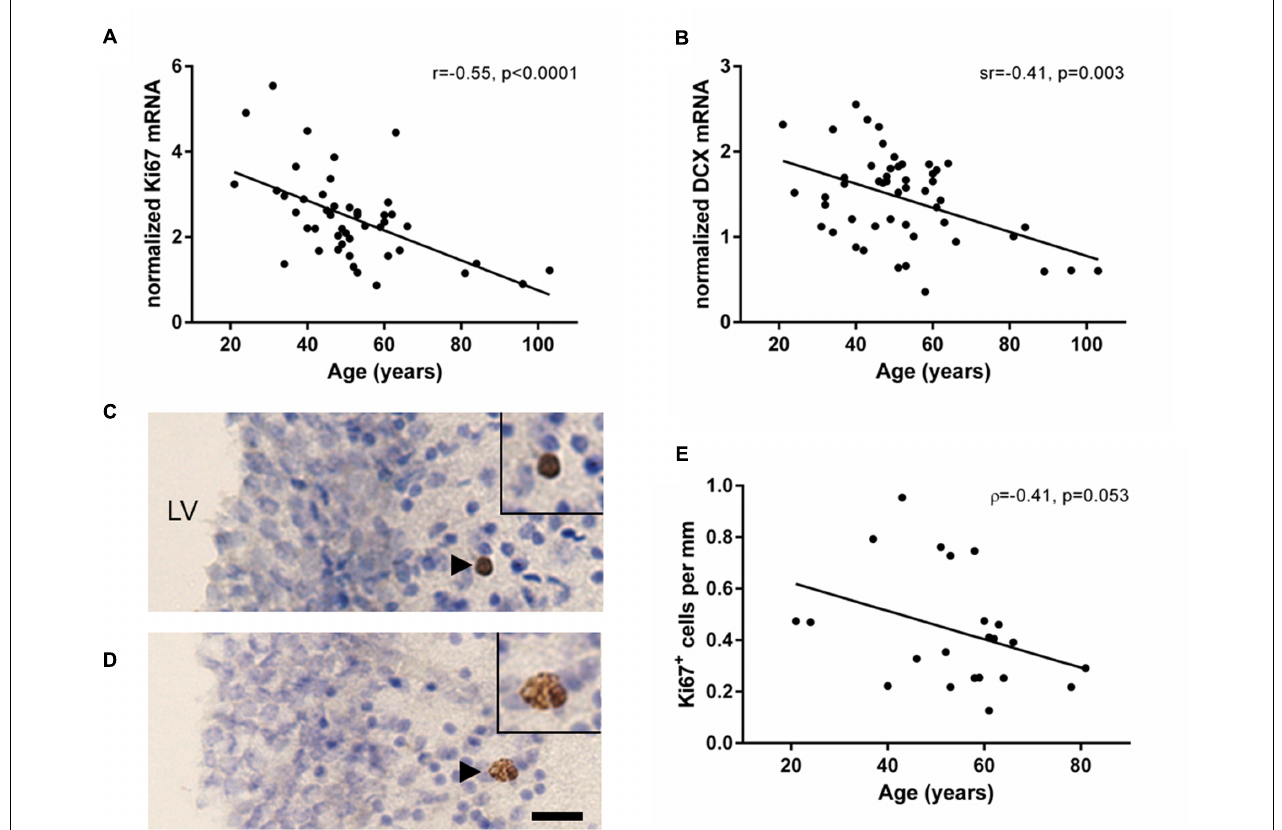
FIGURE 1 | Markers of cell proliferation and immature neurons decreased with age in the human SEZ. Cell proliferation (Ki67) and immature neuron (DCX) transcripts were measured by qRT-PCR and normalized to the geometric mean of two housekeeping genes. Ki67 (A) and DCX mRNAs (B) were negatively correlated with age in the SEZ of individuals ranging from 21 to 103 years of age. Ki67 immunohistochemistry was performed in a subset of individuals of the entire cohort ranging from 21 to 81 years of age. Ki67 immunoreactive cells occurred individually, as doublets or small clusters in the lateral wall of the lateral ventricle (C,D) . The total number of Ki67 immunoreactive cells in three immunostained sections were counted and normalized to total length of the SEZ. The mean density of Ki67 immunoreactive cells decreased with age; however, this correlation was just at statistical significance (E) . Scale bars = 20 µ m. LV, lateral ventricle; r, Pearson’s product-moment correlation coefficient; ρ , Spearman’s rank correlation coefficient; sr, semi-partial correlation coefficient.